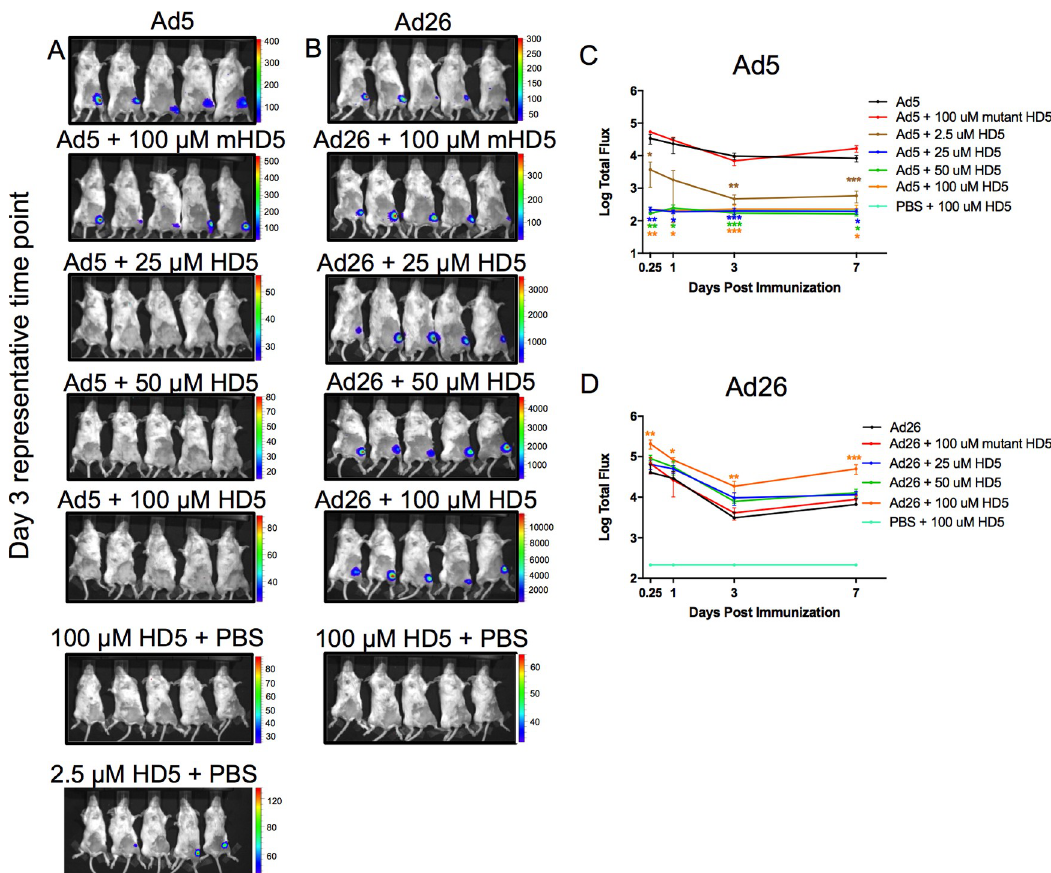
Fig 3. In vivo luciferase transgene expression by Ad5 and Ad26 ± HD5 pretreatment. Animals were pretreated with a dose titration of 2.5 μ M– 100 μ M HD5, 100 μ M mutant HD5 (linear peptide), or PBS ± 100 μ M HD5 and immunized i.m. with (A) Ad5 (10 9 vp) or (B) 25 μ M– 100 μ M HD5 with Ad26 (10 9 vp) vectors encoding luciferase transgene cassettes. Representative day 3 IVIS images are shown for each experimental condition assayed. The Total Flux (photons/sec/cm 2 /radian) released by luciferase activity was averaged for (C) Ad5 and (D) Ad26 at each time-point. n = 5 animals per group. The data are representative of experiments performed two times. Mean ± SEM are shown. ��� p < 0.001, �� p < 0.01, � p < 0.05, one-way ANOVA test (compared to virus only